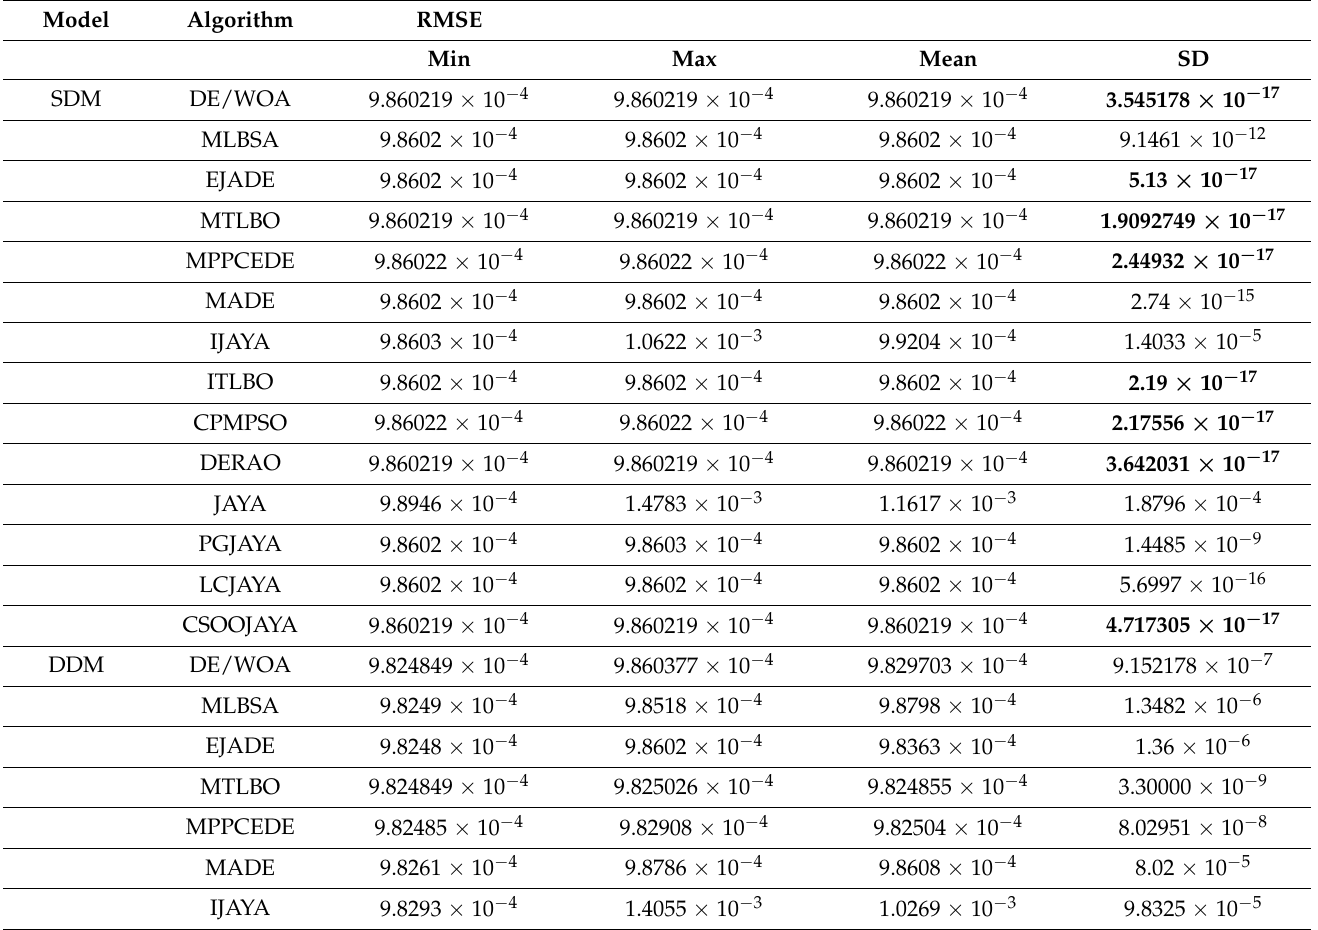
Table 11. Comparison of statistical results for PV